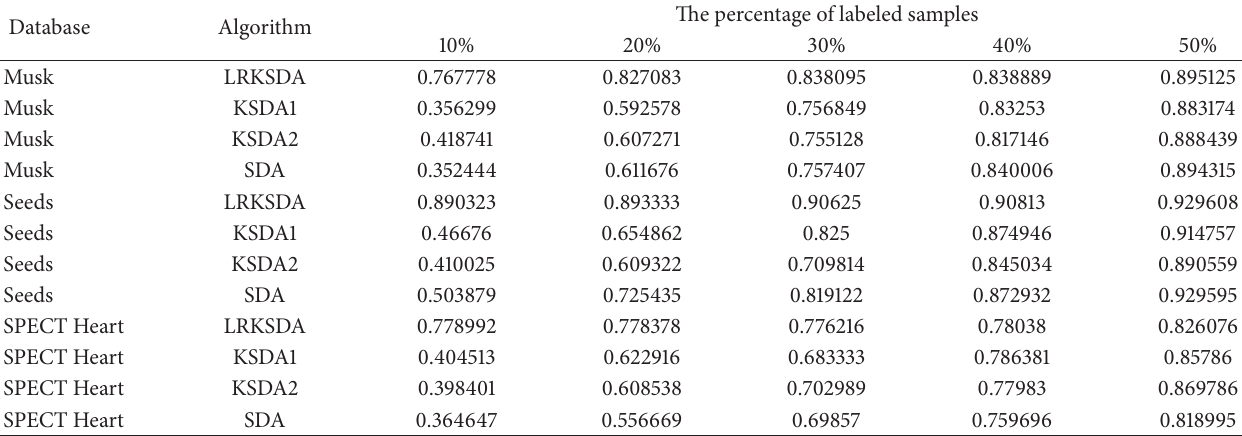
Table 3: Classification accuracy of different graphs on Musk, Seeds, and SPECT Heart databases.